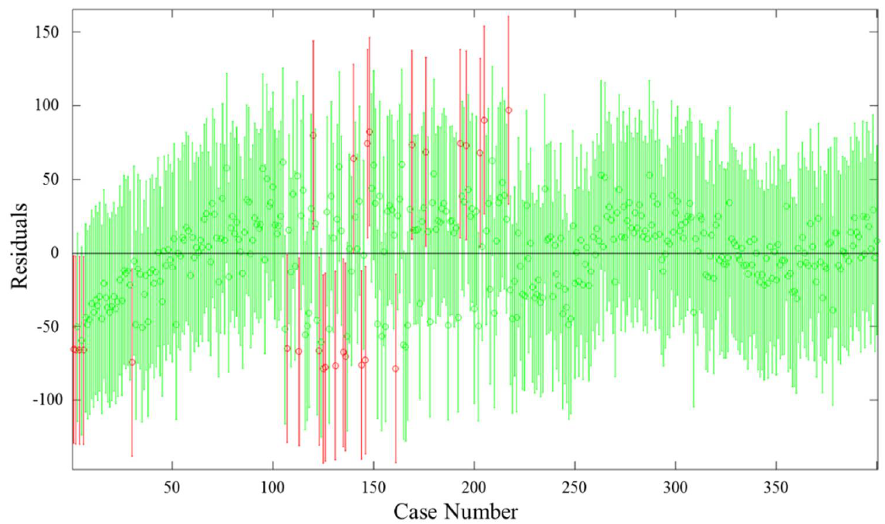
Figure 2. Fitting residual map of “Cooling capacity-Power” model.